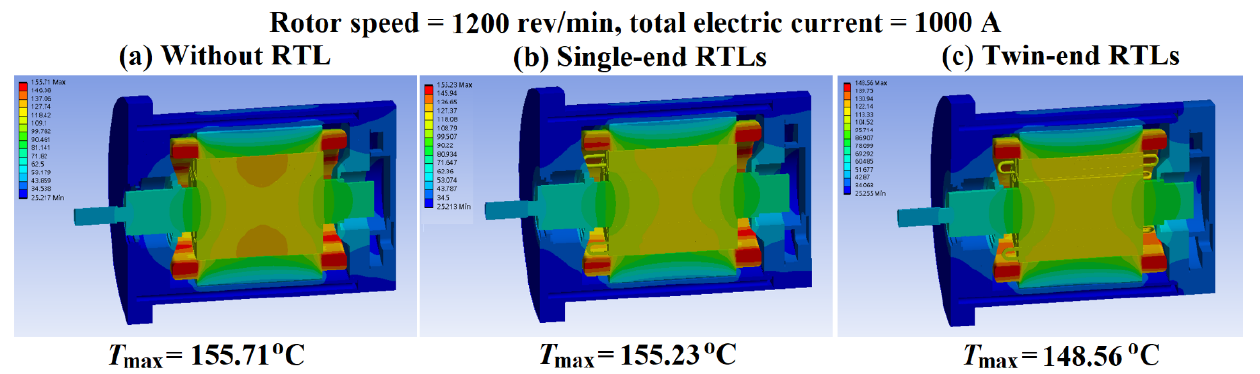
Figure 11. Detailed temperature distributions of the PMSEMs ( a ) without RTL and with ( b ) single- end RTLs; ( c ) twin-end RTLs at rotor speed of 1200 rev/min and total electric current of 1000 A.